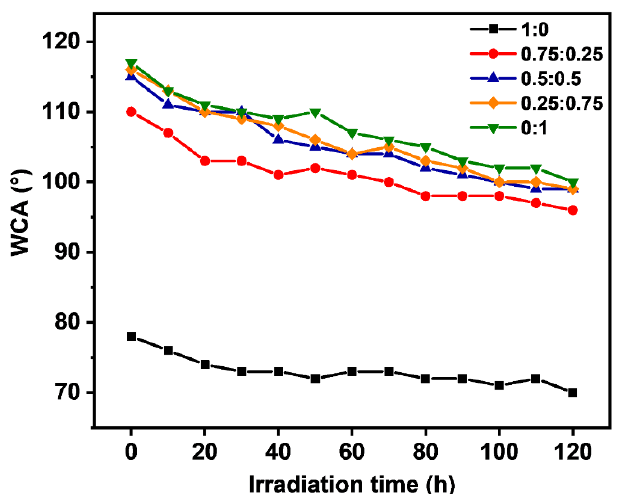
Figure 5. Change of WCA with UV irradiation time for waterproof coatings with different molar ratios of ET:FA.